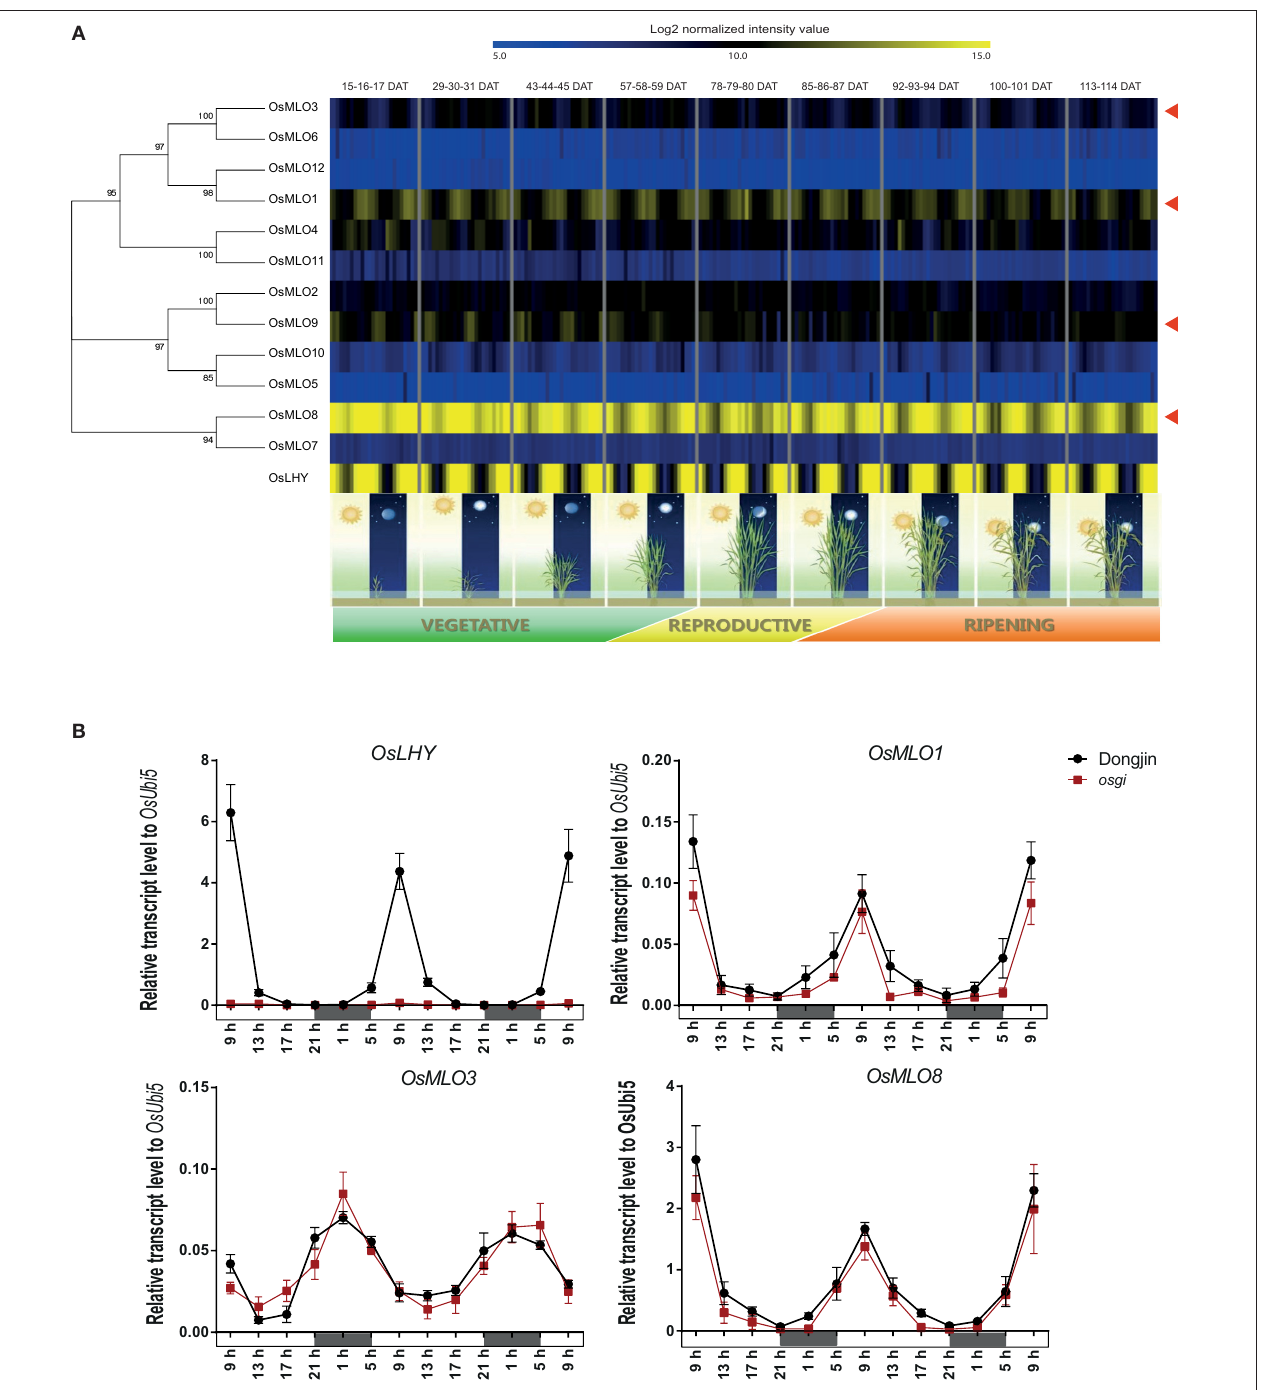
FIGURE 4 | Diurnal expression patterns of OsMLO genes (red arrows indicate diurnal rhythm) in mature leaves, using available Agilent 44k array data over entire plant life span (A), or evaluated at 13 time points over 48-h period in “Dongjin” rice and osgi mutant (B). As a standard marker gene for diurnal rhythm, expression of OsLHY was peaked during daytime. OsUbi5 was served as internal control. DAT, days after transplanting. Continuous white and black bar indicates day and night time, respectively.